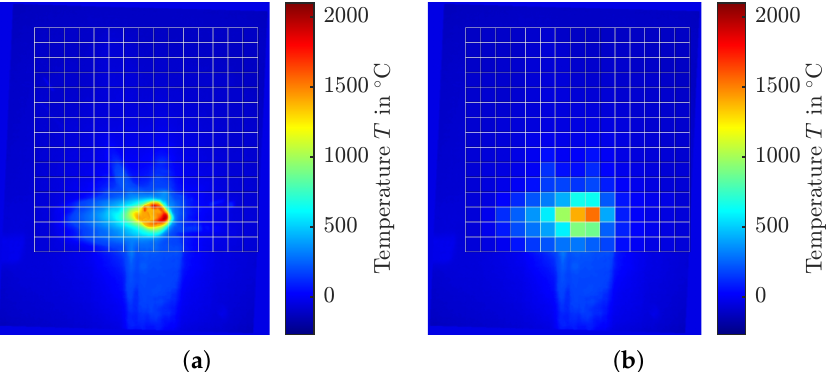
Figure 6. False color image with predefined grid before ( a ) and after ( b ) spatial downsampling at time instance k = 4000.